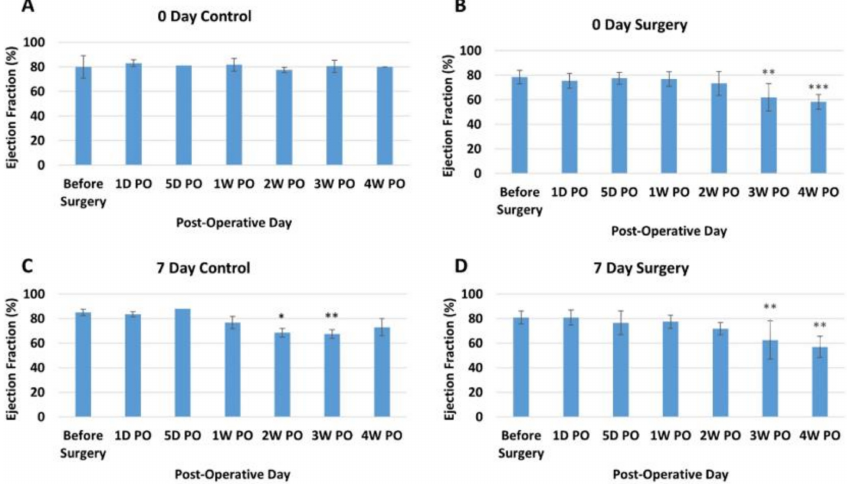
Figure 2. Average ejection fraction (percentage) at different time points for each group. ( A ) Zero-day control group. ( B ) Zero-day surgery group. ( C ) seven-day control group. ( D ) seven-day surgery group. *, **, and *** represent a significant difference ( p < 0.05) between before surgery and the labeled time point.